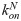
Dependence of microtubule-neurofilament segregation on konN.Each curve plots the mean of the PDMT over time averaged over five realizations, and the error bars are the standard deviations. The rate konN is reduced to 50% (blue), 20% (green), and 0% (red) of the value in Fig 4 at t = 1 h. All other parameters are the same as in Fig 4.